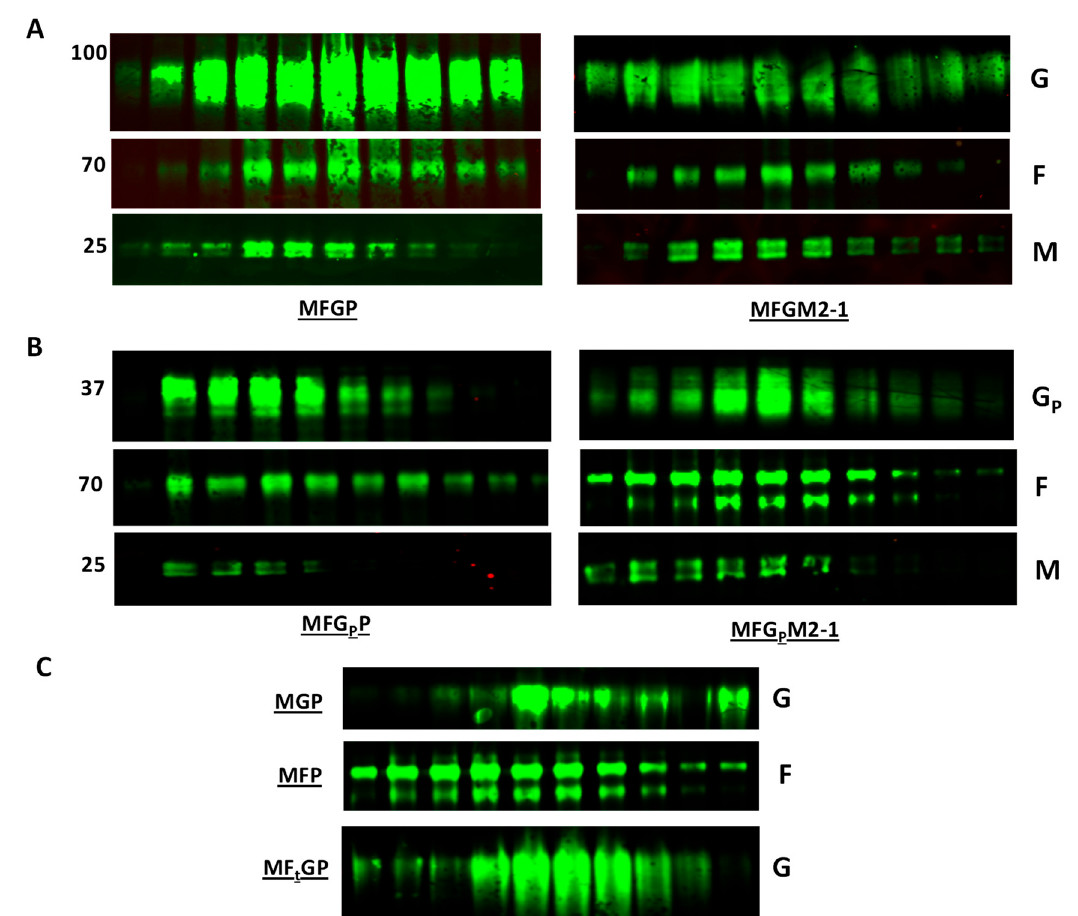
Figure 1. Generation and expression of F and G on RSV VLPs . 293F cell line expressing RSV gene M, F (or F t ), G (or G P ), and P or M2-1 were induced for 72 h in 2 μ g/mL doxycycline. Cells were harvested and low-speed centrifugation performed to separate cells and VLPs-containing supernatant. VLPs were filtered through 0.45 μ m filter to clear cell debris, layered on top of a 20% sucrose cushion and subjected to centrifugation at 12,200× g for 2 h, 4 °C. VLP pellets were resuspended in sterile PBS and subjected to centrifugation through a 20–60% sucrose gradient at 11,000× g for 12 h, 4 °C. A total of 10 fractions were collected and analyzed by immunoblotting using 3D3 (human anti-G antibody), motavizumab (human anti-F antibody), and rabbit serum anti-M antibody. ( A ) VLPs MFGP and MFGM2-1. Note that high levels G, F, and M are detected in similar fractions, ( B ) VLPs MFG P P and MFG P M2-1. G P , truncated G: aa 1-86+155-206. Note that high levels G, F, and M are detected in similar fractions, ( C ) MGP, MFP, and MF t GP VLPs. F t , truncated F: aa 496–574. Note that the expression level of G is less without F (MGP) than when F t is co-expressed with G (MF t